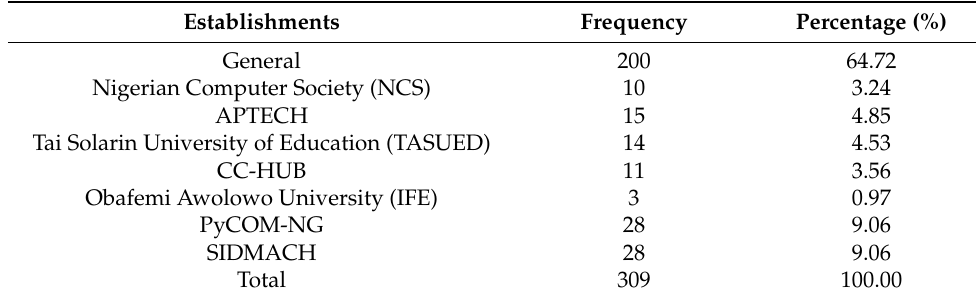
Table 9. Distribution of respondents based on their IT